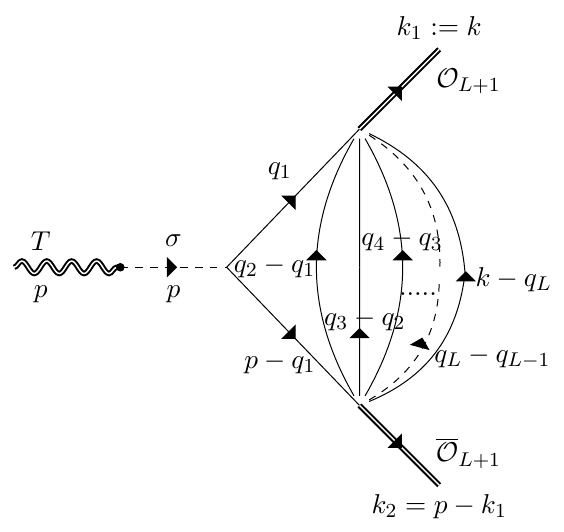
Figure 2 . The diagram determining the leading contribution to the three-point function